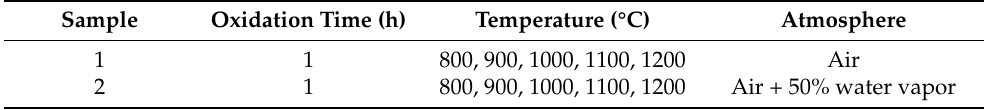
Table 2. Oxidation experiment parameters.